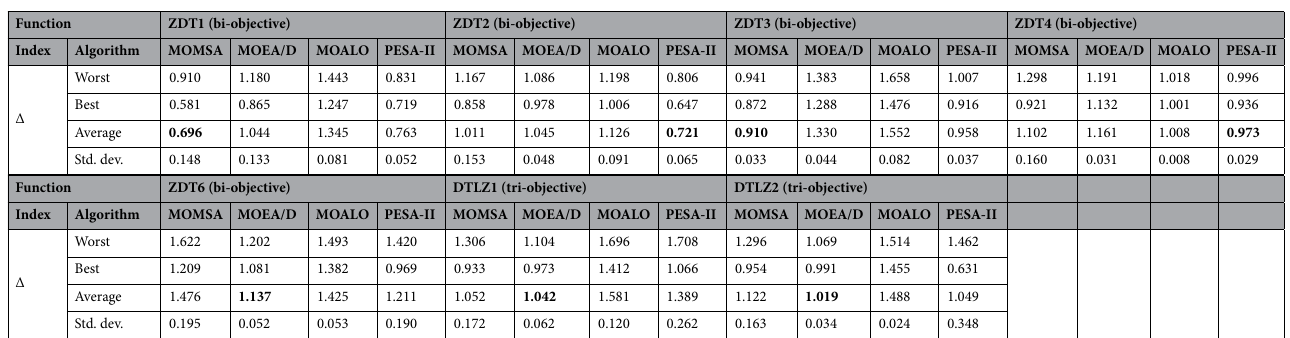
Table 7. Statistical results for Δ evaluation metrics on ZDT bi-objective and DTLZ tri-objective test function suite. The bold values in the table represnt the best values obtained by the utilized algorithms for each benchmark